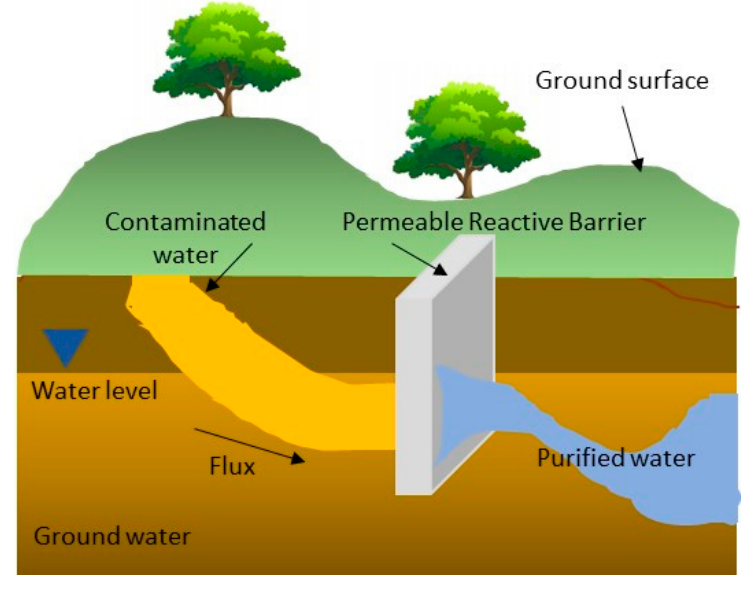
Figure 3 . Scheme of Permeable Reactive Barriers (adapted from [50]). Figure 3. Scheme of Permeable Reactive Barriers (adapted from